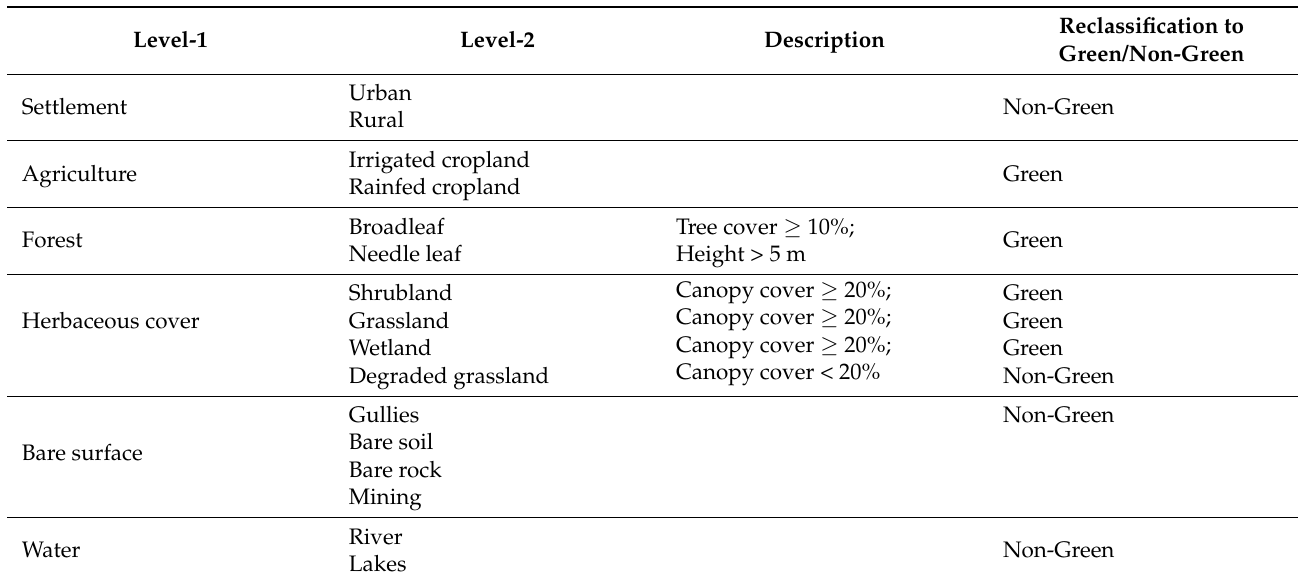
Table A3. Land cover classes included in training dataset collected by FAO and Ministry of Agriculture and Food Security in Lesotho,